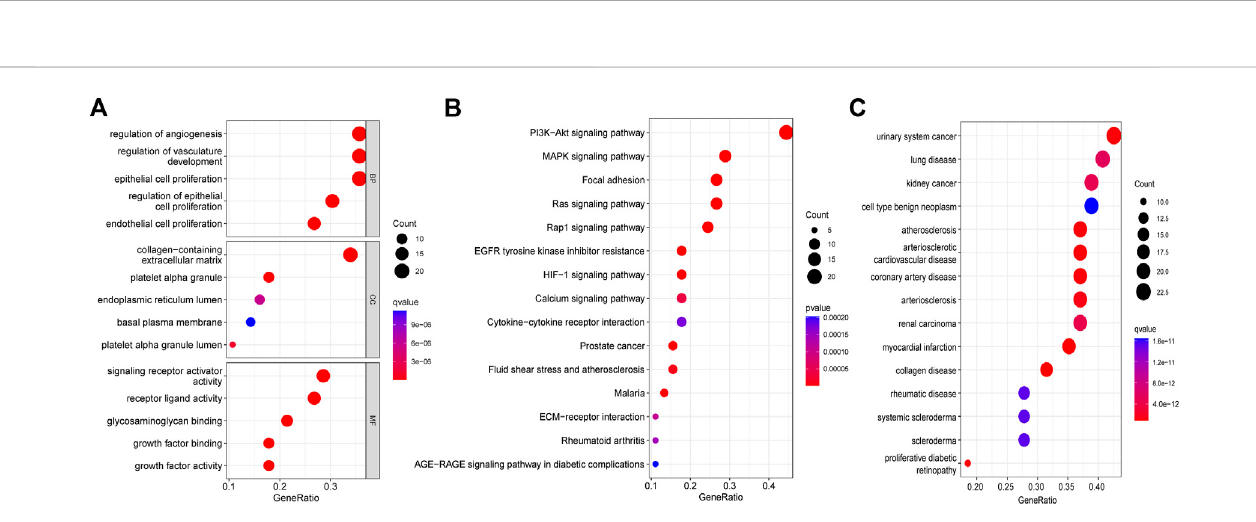
FIGURE 3 Functional enrichment analysis of differential genes. (A) GO. (B) KEGG. (C)